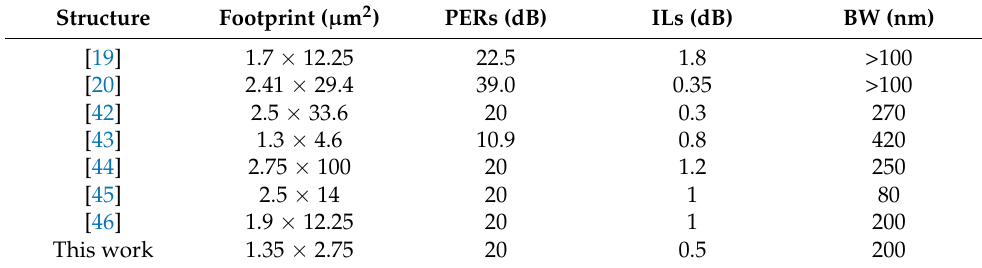
Table 1. Performance comparison of SWGM ‐ based PBSs.